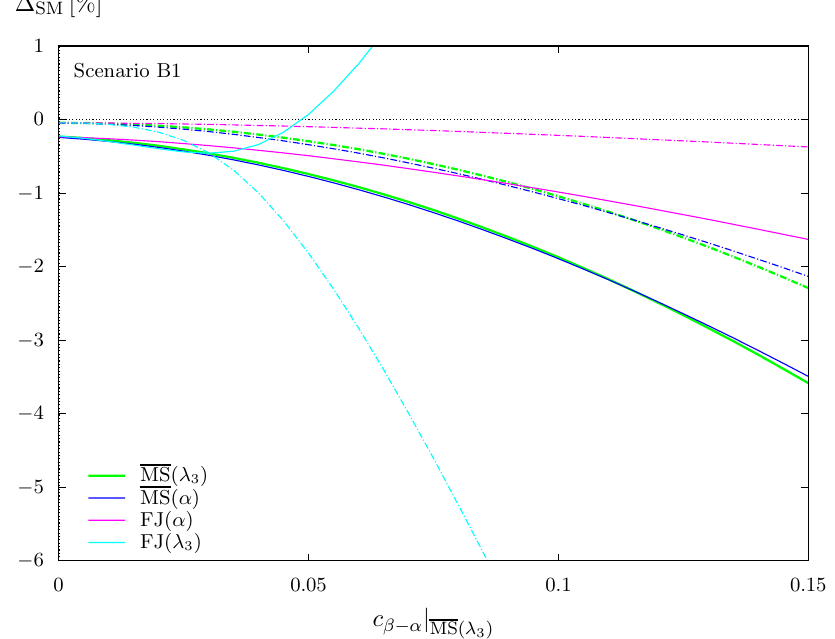
Figure 26 . The h 4 f width at LO with NLO conversion (dashed) and NLO EW+QCD (solid) in ! scenario B1, normalized to the respective SM values where the SM Higgs-boson mass is M h . The input is de(cid:12)ned in the MS( (cid:21) 3 ) scheme, and the results in the four schemes are displayed using the colour code of (cid:12)gure